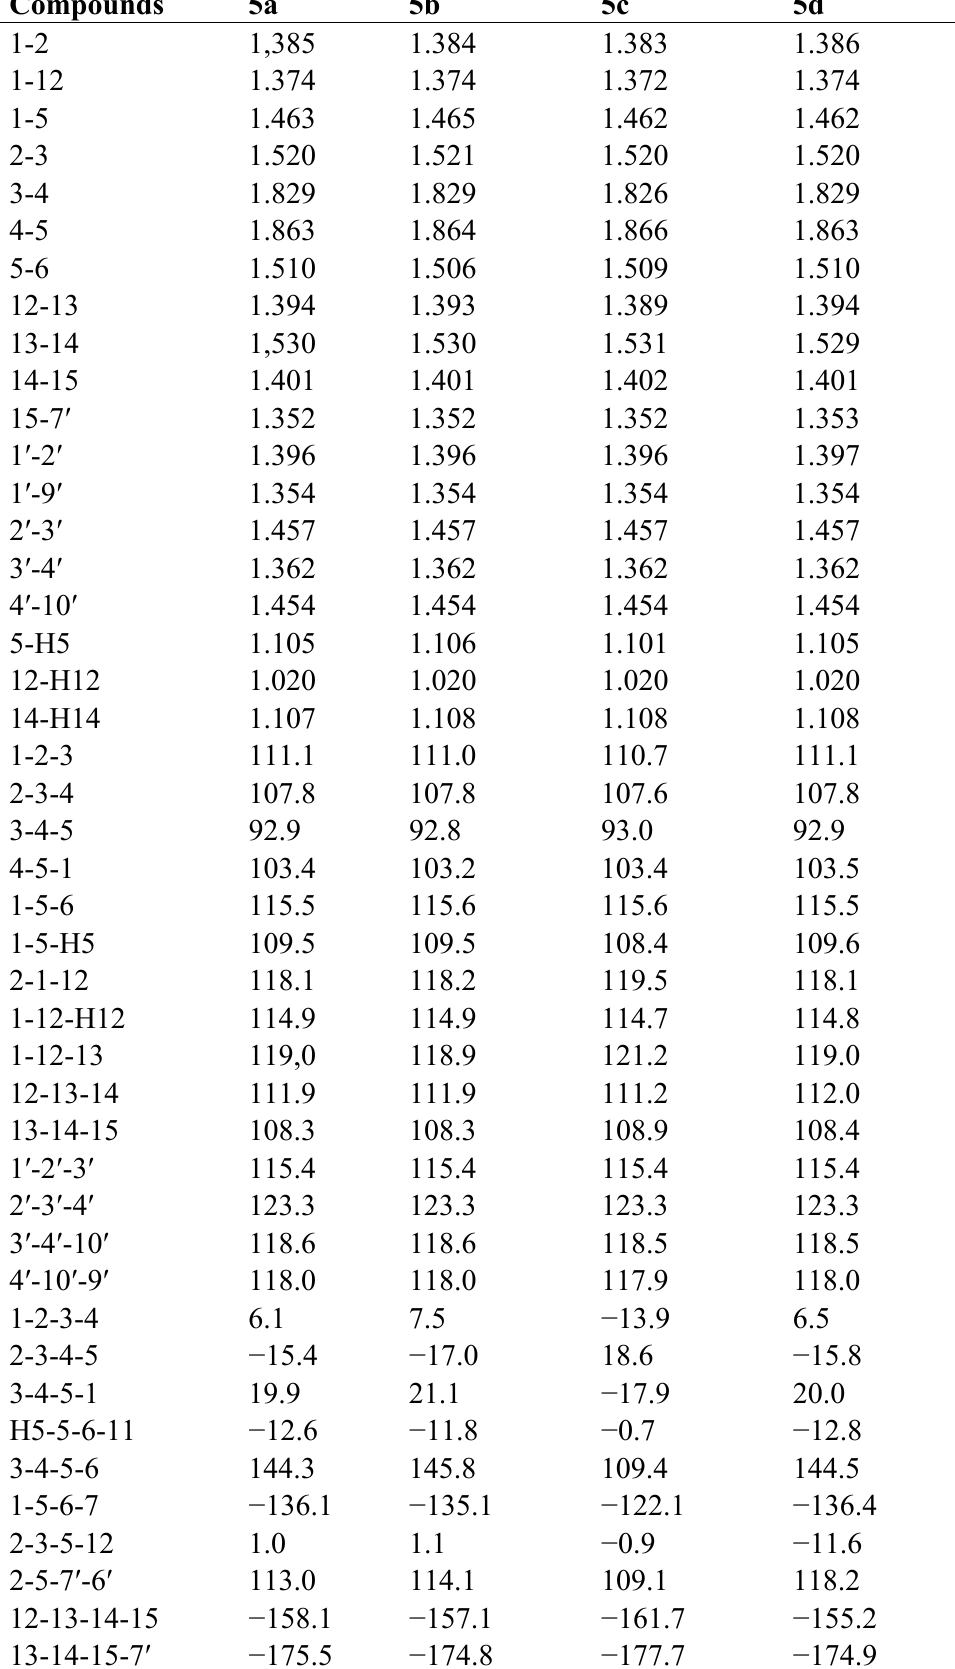
Table 1 . DFT/B3LYP optimized geometrical parameters a for 5a – d